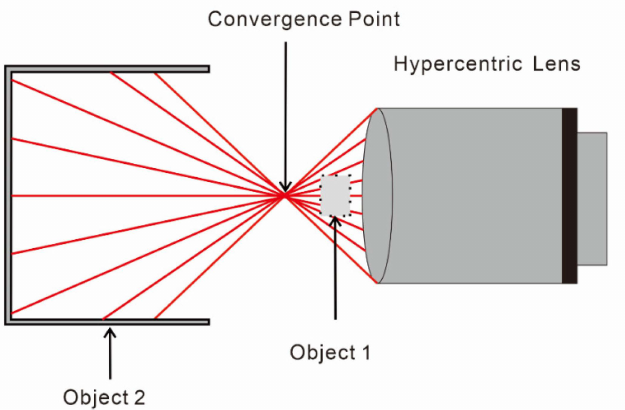
Figure 2. Principle of the hypercentric